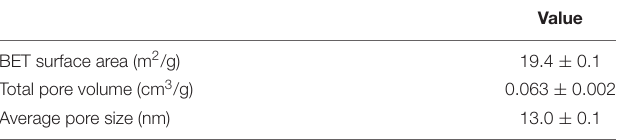
TABLE 6 | Pore properties of